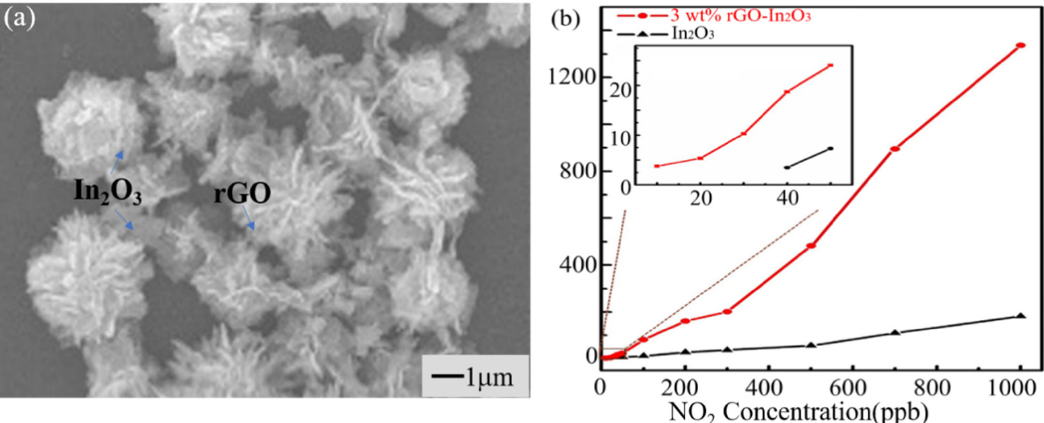
Figure 8. rGO-In 2 O 3 gas sensor. Adapted from [130] copyright (2017), with permission from Elsevier. ( a ) The morphology of rGO-In 2 O 3 composite nanostructure; ( b ) the response of rGO-In 2 O 3 composite nanostructure to NO 2 .